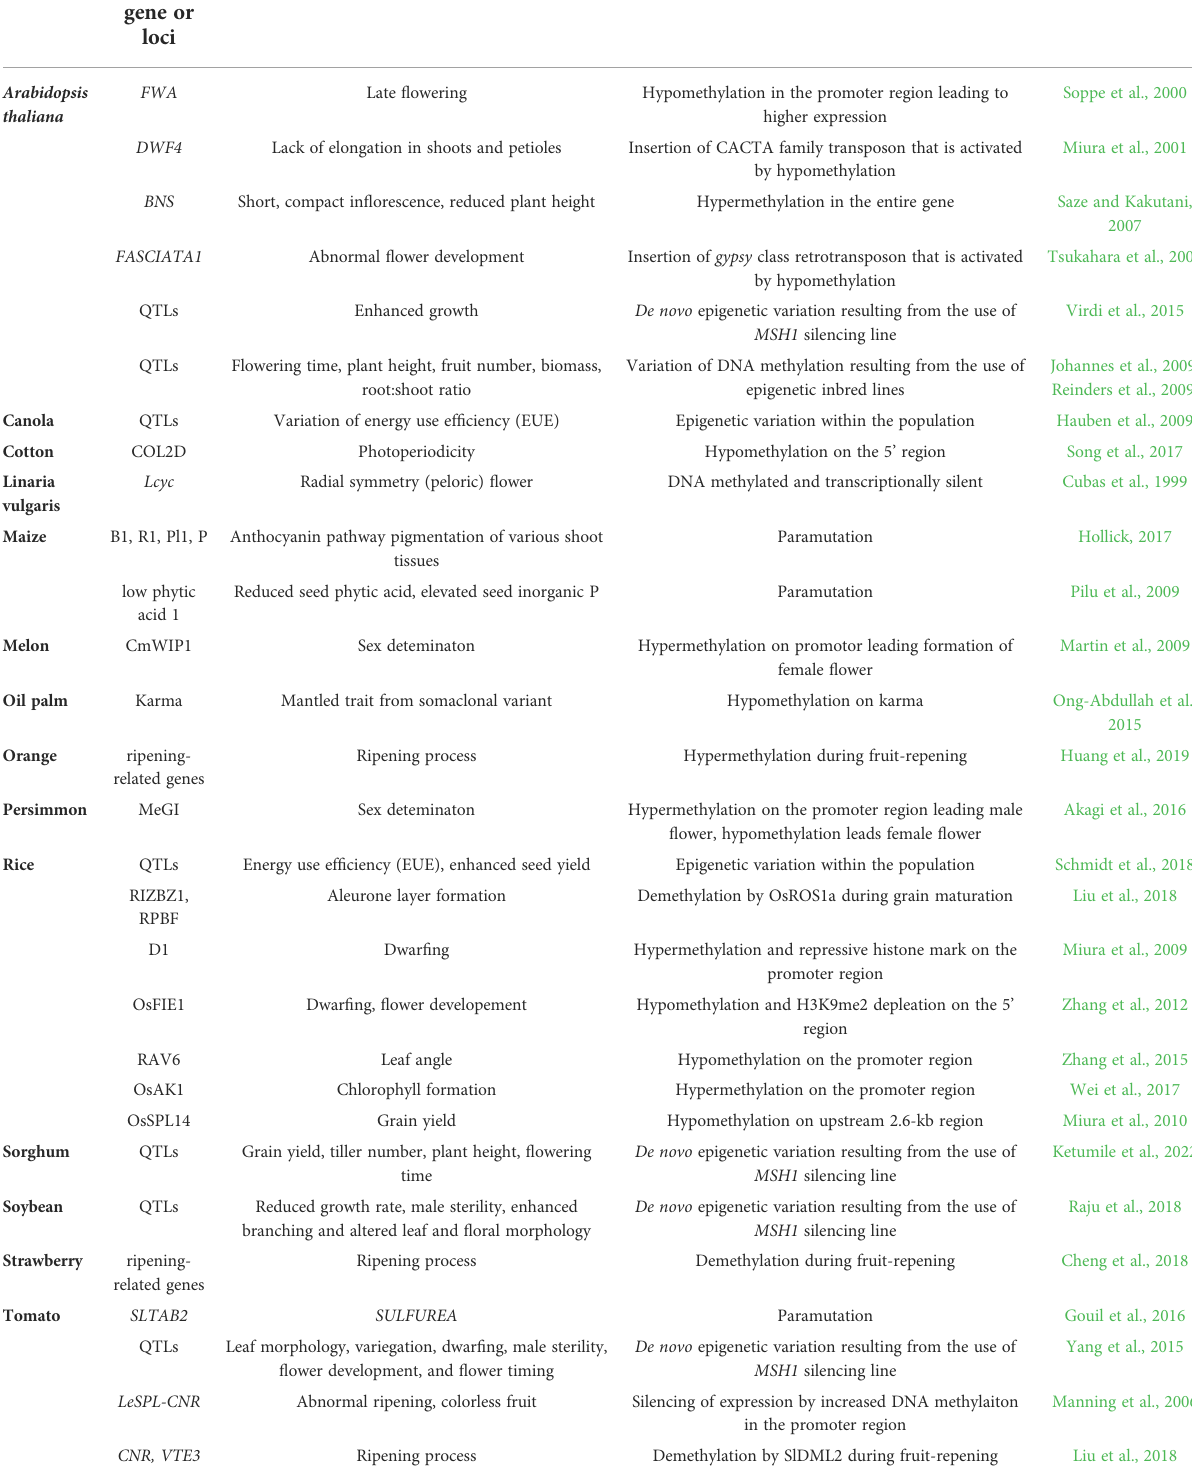
TABLE 1 Summary of the epigenetic mechanism leading to various phenotypes in different plant